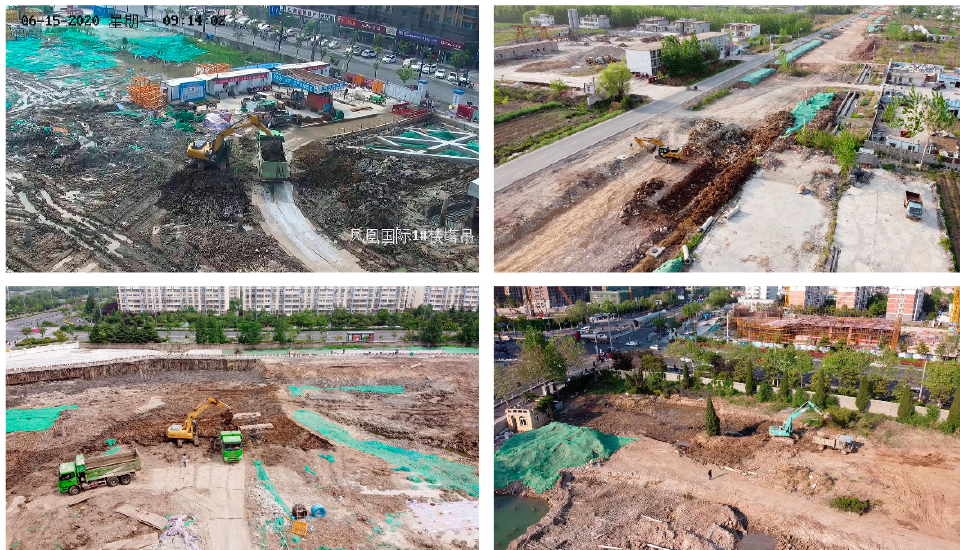
Figure 4. Examples of video data collected from actual earthmoving sites. The two Chinese characters in the first photo in the upper left corner express the recording time of this video (in the upper left corner of the picture: 06-15-2020, Mon, 09:14:02) and the surveillance camera ID (in the lower right corner of the picture: the tower of Phoenix International Building #1).